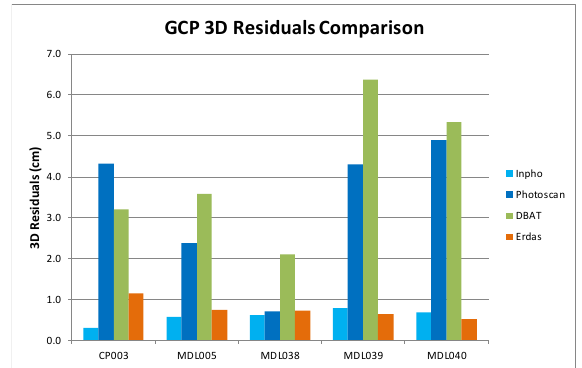
Figure 4. Comparison of GCP residuals.